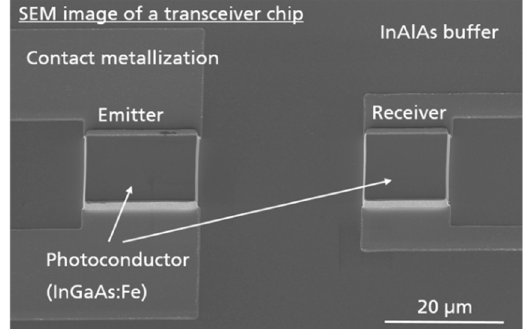
Figure 2. Scanning electron micrograph of a monolithically integrated THz transceiver chip. The emitter (strip-line antenna with a gap size of 15 µm) is located on the left, the receiver (also strip-line antenna with 15 µm gap width) on the right. The midpoints of the two photoconductive mesas lie only 45 µm apart.